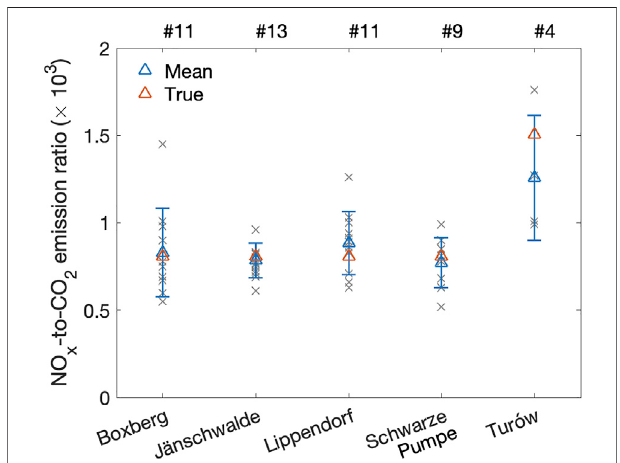
FIGURE8| Source-speci fi cNO x -to-CO 2 emissionratiosforeachpower station. Grey symbols indicate estimates from individual plumes while blue symbols show the mean value and the standard deviation. Orange symbols indicate the true emission ratio. The number of plumes analyzed are indicated above the fi